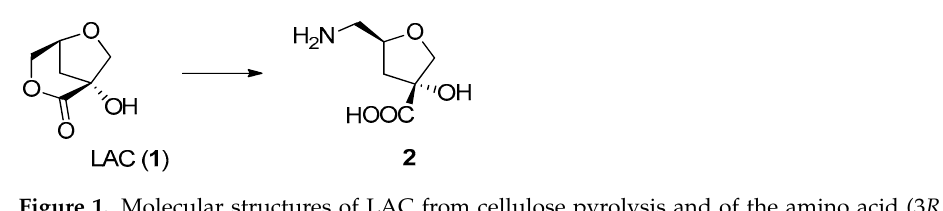
Figure 1. Molecular structures of LAC from cellulose pyrolysis and of the amino acid (3 R ,5 S )-5-(amino-ethyl)-3-hydroxytetrahydrofurane-3-carboxylic acid ( 2 ).